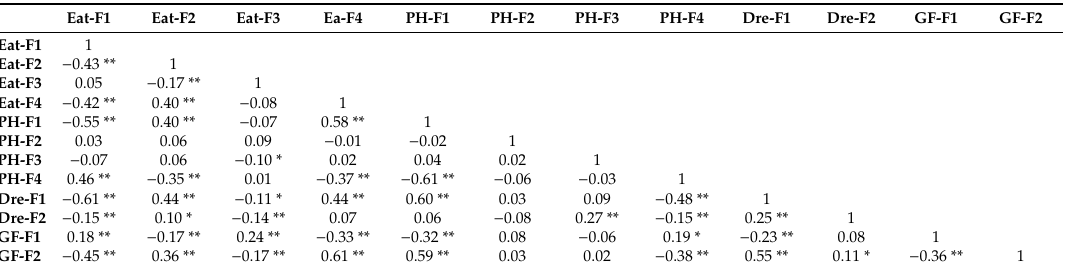
Table 12. Correlations between factors.